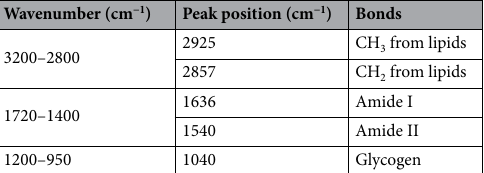
Table. 2.. Analysis of selected signals with assignment of characteristic chemical bonds 44